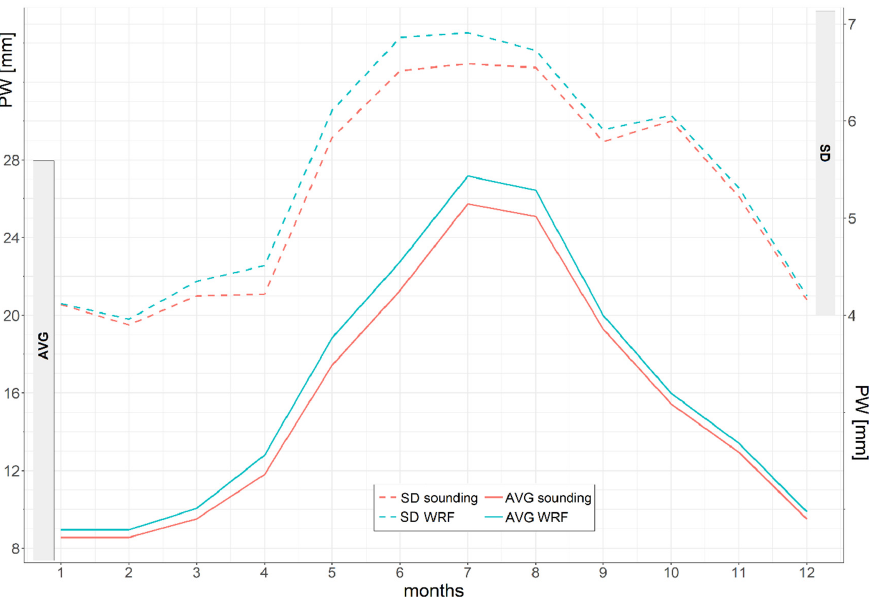
Figure 2. Monthly means (AVG) and standard deviation (SD) of PW (mm) from the WRF model and from soundings for the whole column of the troposphere in the years 2001–2010.